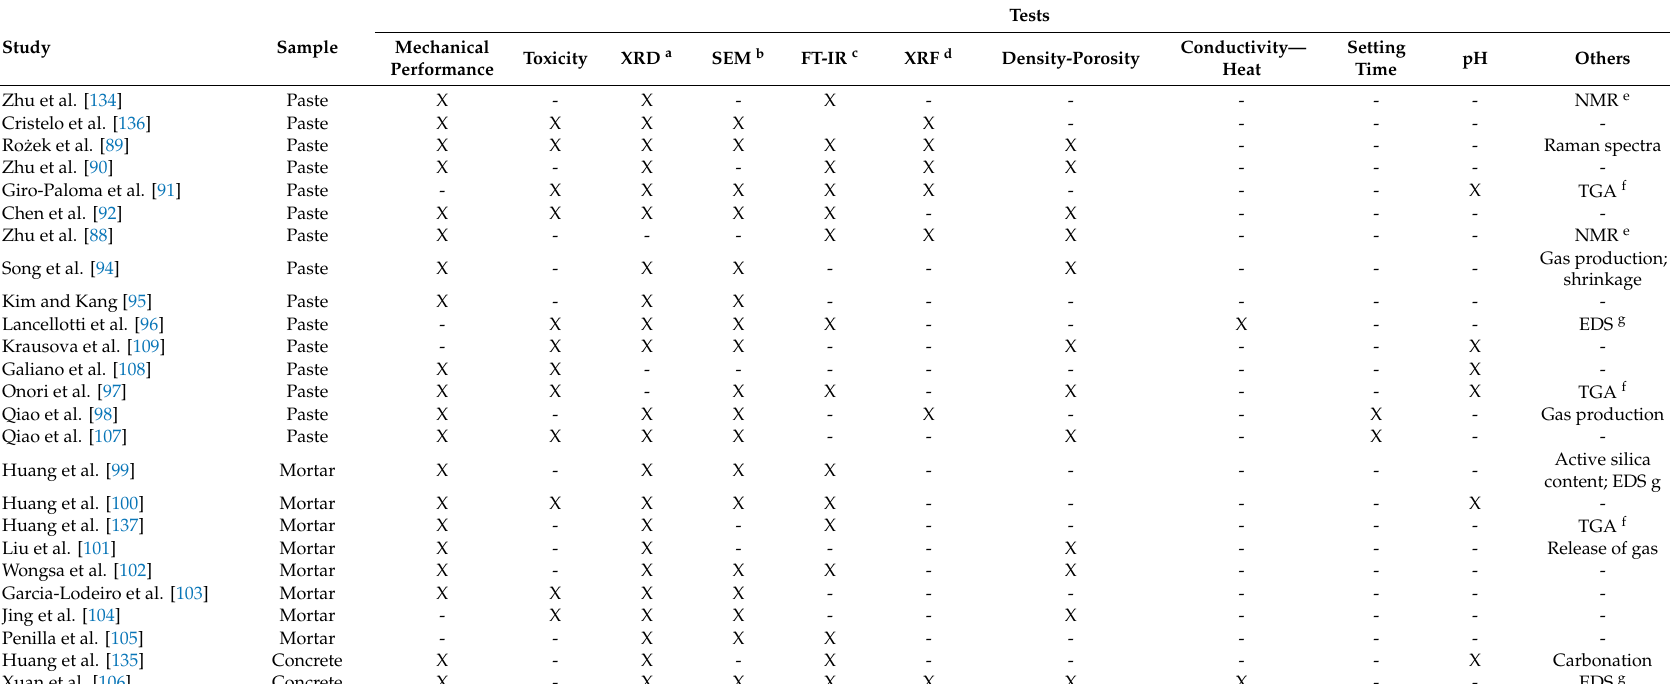
Table 2. Studies related to alkali-activated construction materials made with